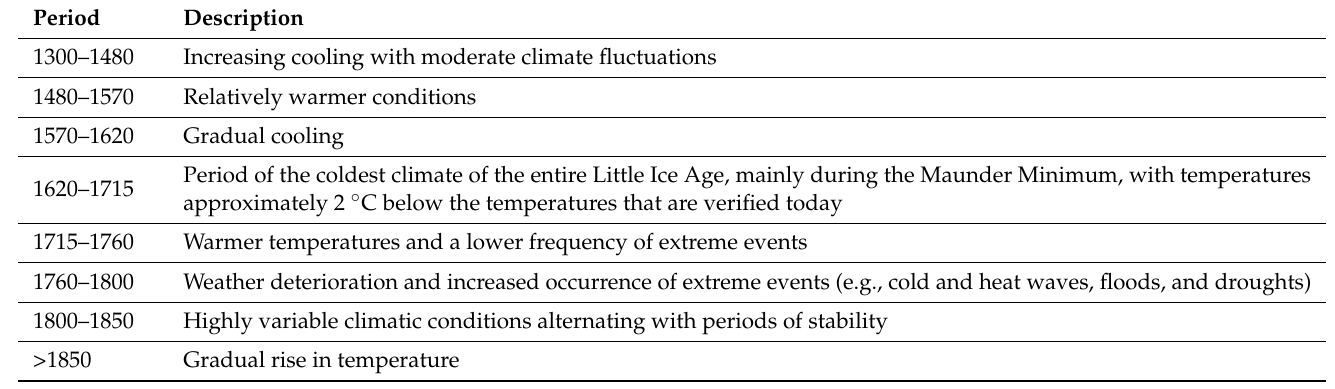
Table 7. Phases of the Little Ice Age according to Oliva et al. (adapted from